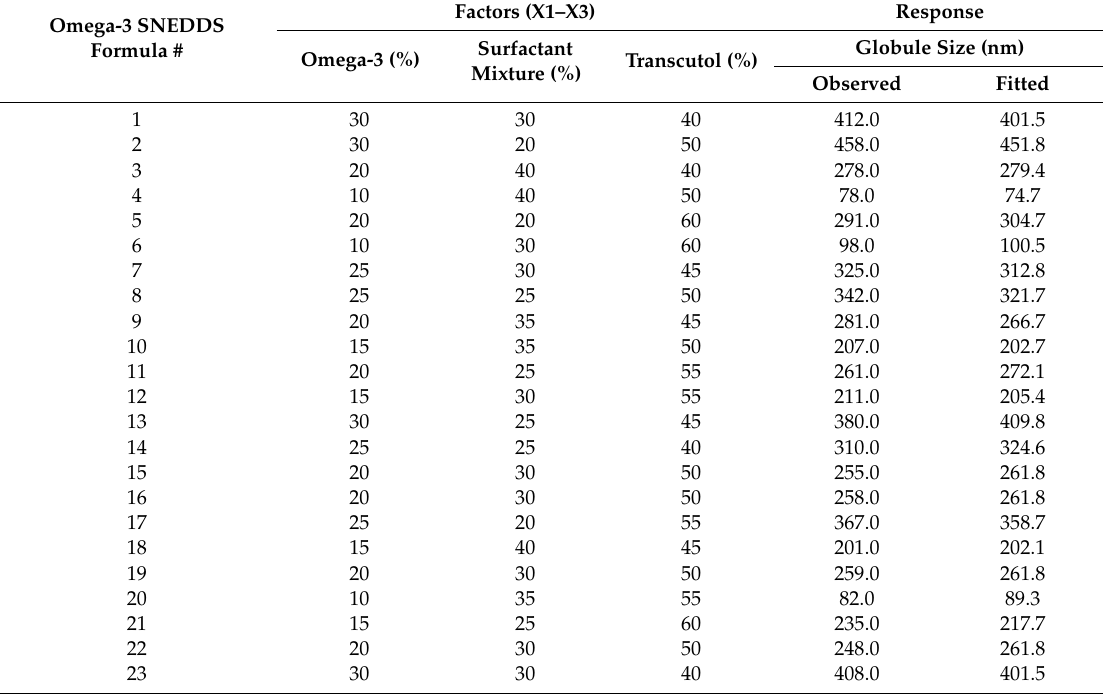
Table 1. Experimental runs and the observed globule sizes (observed and fitted